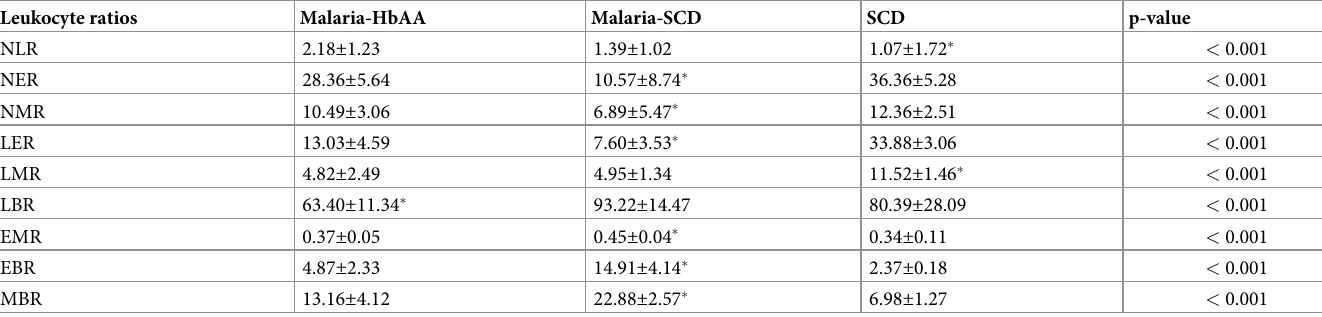
Table 6. Association of leukocyte ratio with malaria-SCD comorbidity. Leukocyte